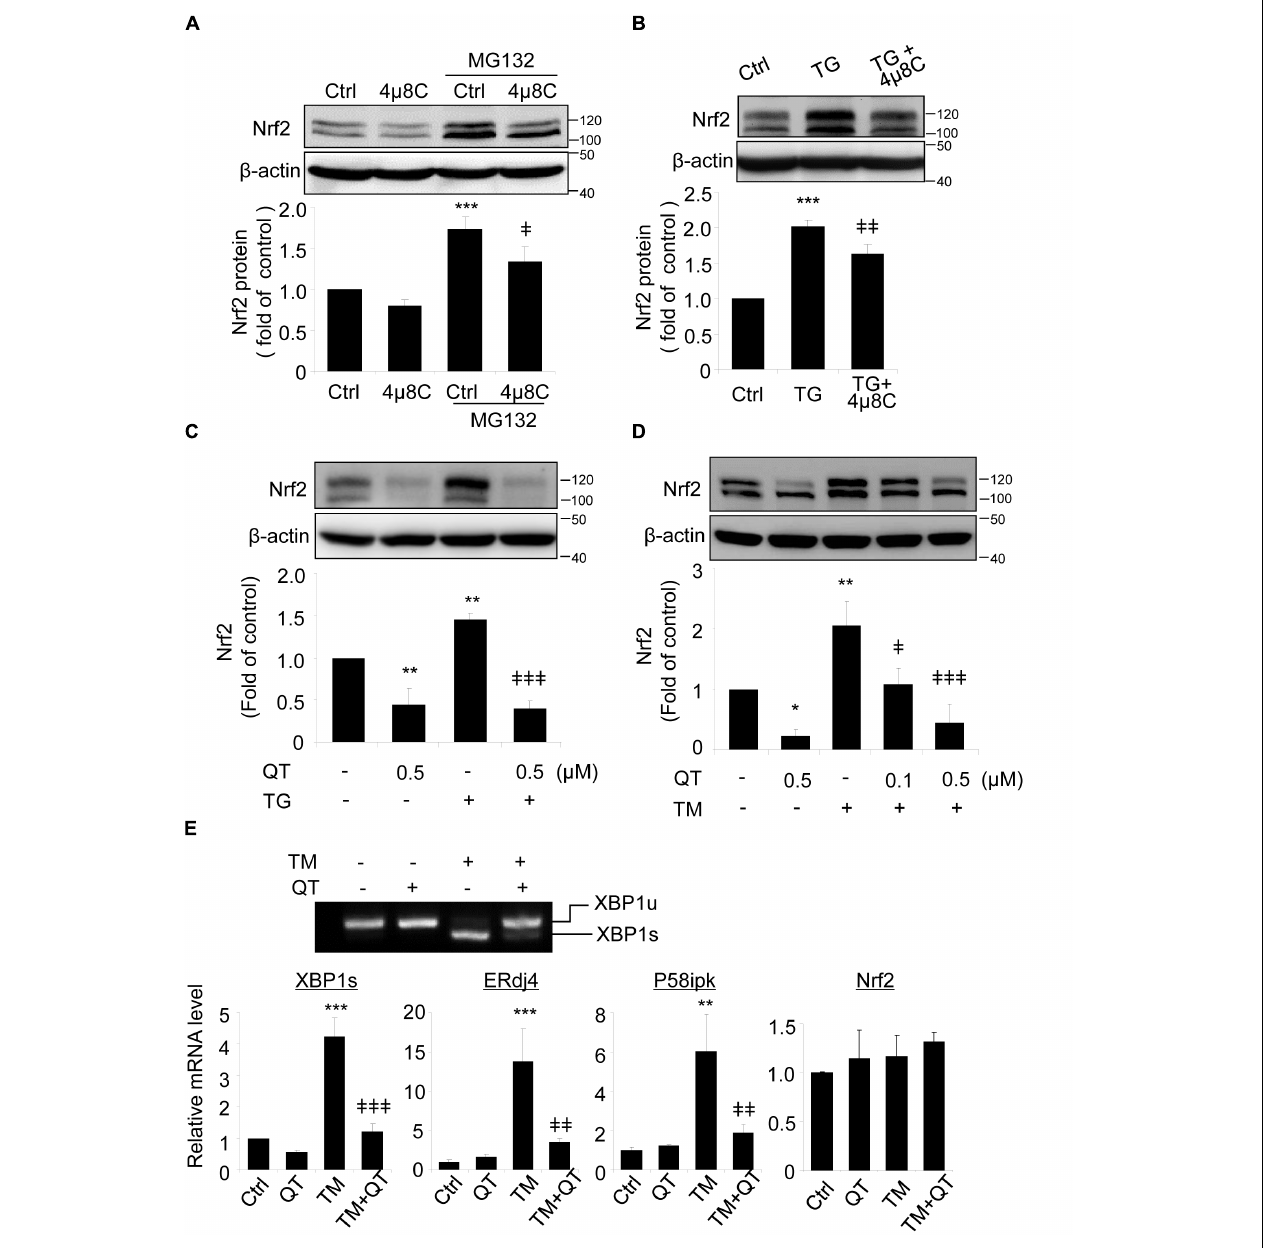
FIGURE 4 | XBP1 splicing inhibitors reduce Nrf2 expression in ARPE-19 cells. (A) ARPE-19 cells were treated with proteasome inhibitor MG132 (10 µ M, 20 min) with or without pre-treatment of 4 µ 8C, an XBP1 splicing inhibitor (25 µ M, 8 h). (B) ARPE-19 cells were treated with ER stress inducer thapsigargin (TG) (10 µ M) with or without 4 µ 8C (25 µ M) for 8 h. Nrf2 expression was detected by Western blot and semi-quantified by densitometry (mean ± SD, n = 3, ∗∗∗ p < 0.001 vs. control, ‡ p < 0.05, ‡‡ p < 0.01 vs. MG132 or TG treated cells). (C,D) ARPE-19 cells were treated with ER stress inducer thapsigargin (TG) (10 µ M) or tunicamycin (TM) (50 ng/ml) with or without quinotrierixin (QT) for 8 h, Nrf2 expression was detected by Western blot and semi-quantified by densitometry. (E) ARPE-19 cells were treated with TM (50 ng/ml) with or without QT (0.5 µ M) for 8 h, XBP1 splicing was detected by RT-PCR. The levels of spliced XBP1, ERdj4, P58ipk and Nrf2 mRNA were determined by real-time PCR. (mean ± SD, n = 3, ∗ p < 0.05, ∗∗ p < 0.01, ∗∗∗ p < 0.001 vs. control, ‡ p < 0.05, ‡‡ p < 0.01, ‡‡‡ p < 0.001 vs. TM or TG treated